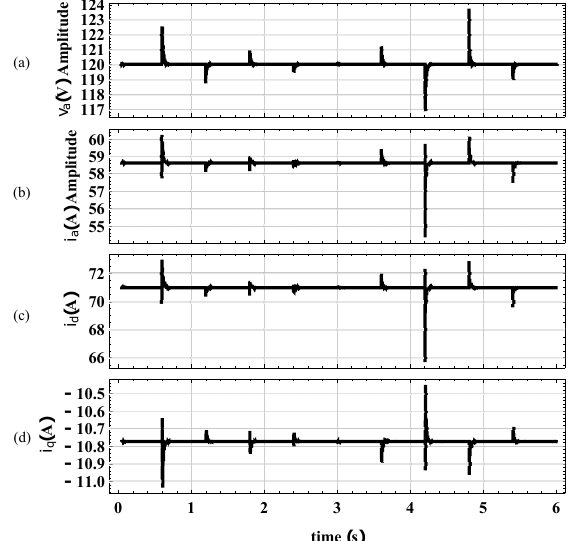
Figure 7. Load ( a ) phase a voltage and ( b ) current amplitudes, ( c ) d and ( d ) q current